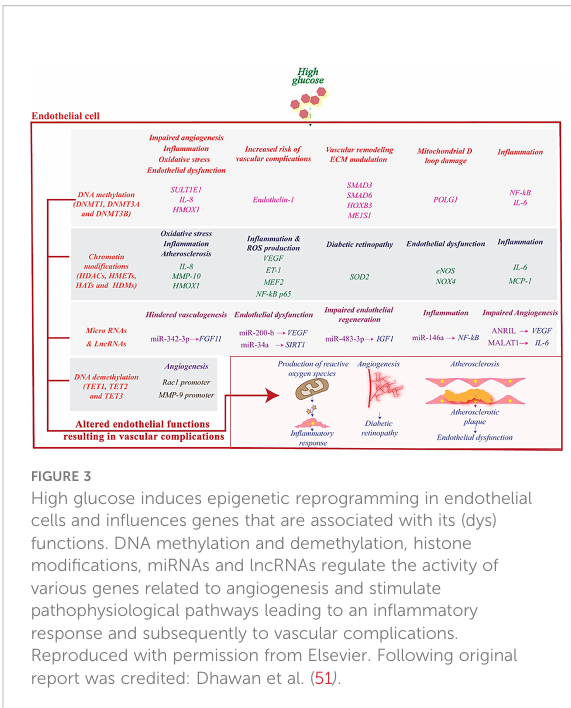
FIGURE 3 High glucose induces epigenetic reprogramming in endothelial cells and in fl uences genes that are associated with its (dys) functions. DNA methylation and demethylation, histone